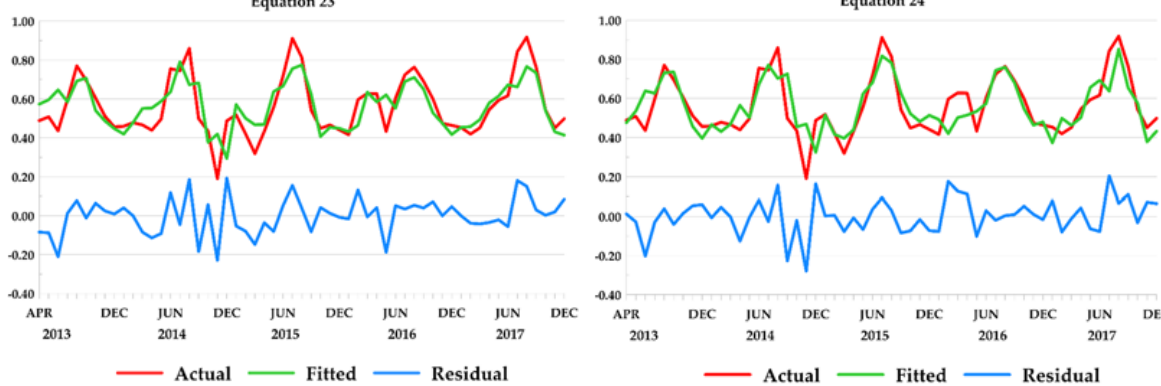
Figure 11. Representation for type of maize aggregate, estimation model and the residuals given by Equations (23) and (24). A similar model considering the dynamic structure of the time series and by means of transference functions is presented in Equation (24). The selected model was